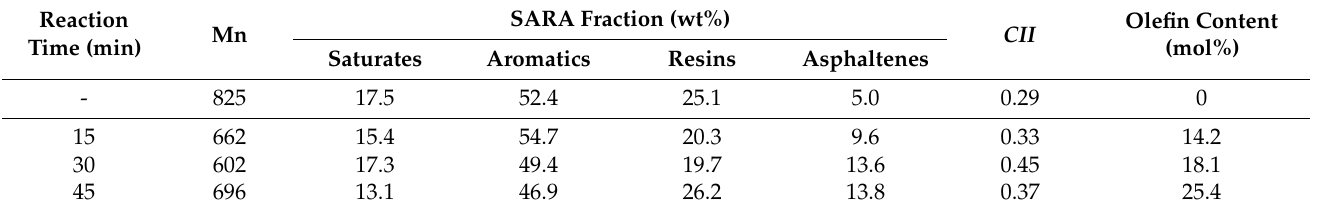
Table 2. Properties of visbreaking products obtained in SC C 6 H 12 . Temperature of 360 °C, SC C 6 H 12 -to-